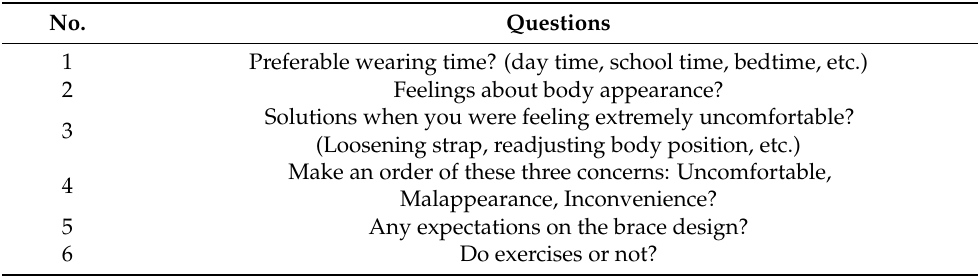
Table 2. Open questions list in the interview